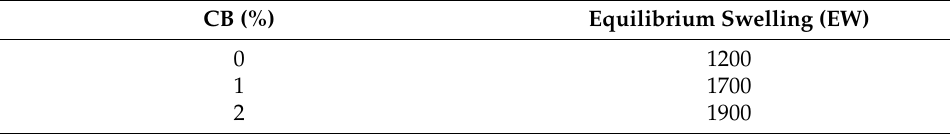
Table 5. Effect of CB weight ratio on water absorption capacity.